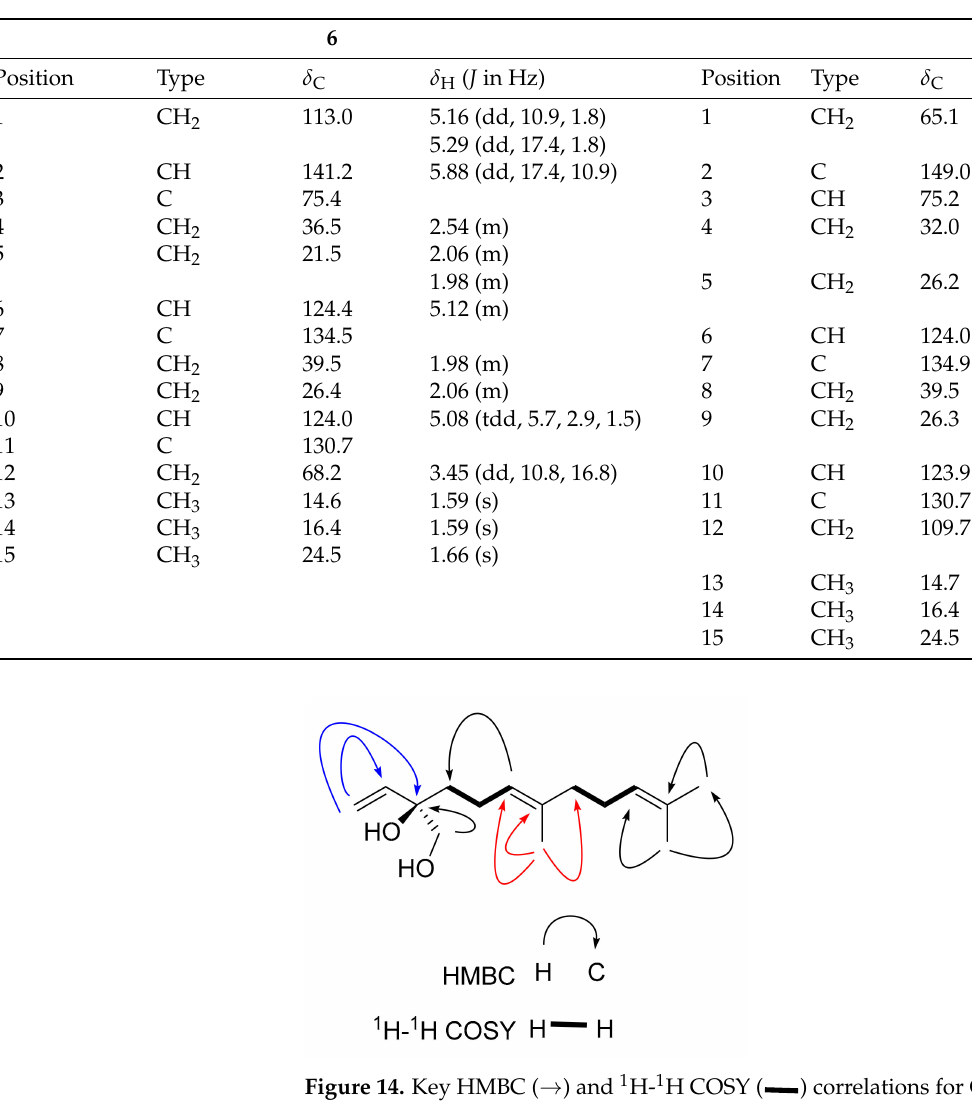
Figure 4. Comparison of the calculated ECD spectrum for (4 S , 5 S , 6 S , 10 S )- 1 at B3LYP/6-31G(d) level with the experimental spectrum of 1 in MeOH. σ = 0.3 eV, shift = − 10 nm. Compound 2 , a colorless needle crystal, [ α ] 23.2